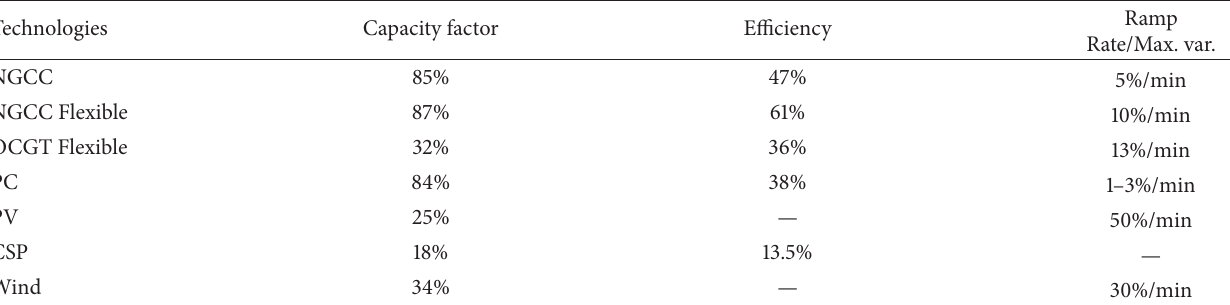
Table 4: Case study economic parameters.